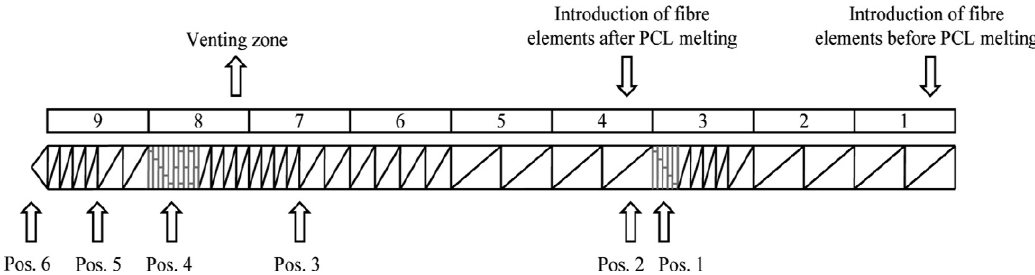
Figure 1. Clextral BC 21 Screw profile used in sample fabrication process, showing positions of introducing hemp fibers before and after poly( ε -caprolactone) PCL melting as well as venting zone on the twin screw extrusion machine.